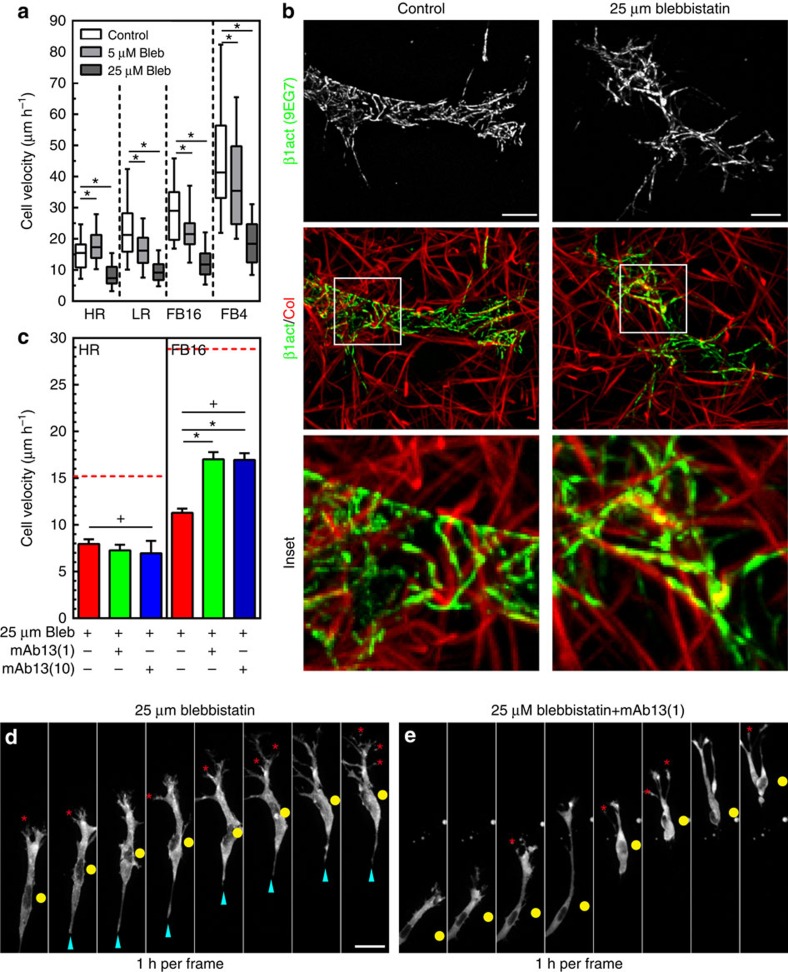
Myosin II contractility regulates 3D migration independent of pore size.(a) Fibroblast 3D migration rates for control (white) 5 μM (light grey) and 25 μM (dark grey) blebbistatin for each ECM architecture. N=3, n=48. (b) MIPs comparing activated β1 integrin (9EG7) in fibroblasts between control and overnight exposure to 25 μM blebbistatin in FB4 collagen. Inset illustrates that activated β1 integrin remains associated with collagen fibrils surrounding the cell body region in the absence of myosin II contractility. (c) Reducing integrin binding with an inhibitory antibody against β1 integrin (mAb13; 1 and 10 μg ml−1) partially rescues contractility-deficient migration, but in a pore size-dependent manner. Red dashed lines indicate control levels. N=3, n≥70.(d) Timelapse series of a fibroblast expressing EYFP-paxillin in FB16 ECM treated with 25 μM blebbistatin (added 30 min before first frame). Numerous protrusions (red asterisks) form but do not aid cell body movement (yellow circle), while an elongated tail (cyan arrowheads) hinders migration. (e) HFF treated with blebbistatin and mAb13 (1 μg ml−1) show fewer protrusions while showing no elongated tails and slipping through the matrix. *P<0.05 (ANOVA). + Significantly different from control conditions; P<0.05 (ANOVA). Errors bars: s.e.m. Scale bars: (b) 10 μm; (d,e) 30 μm.